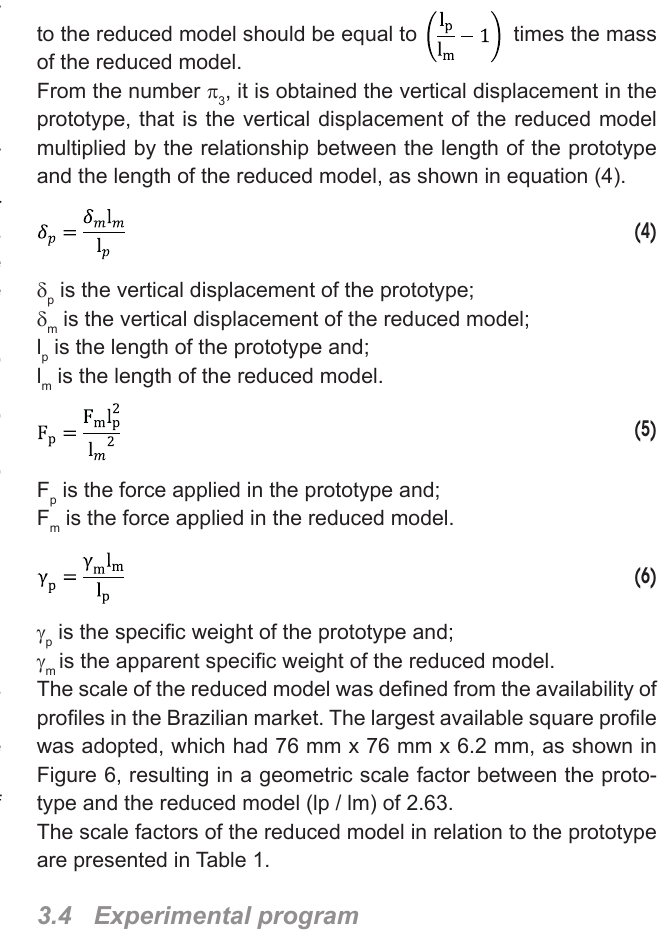
Scale factors of the reduced